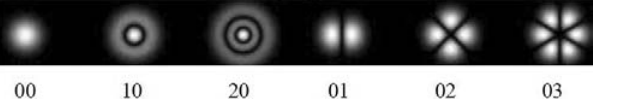
Fig. 2. Diagrams of intensity distributions of di®erent Laguerre – Gaussian modes. The two numbers represent the radial order p and azimuthal order l in the sequence.